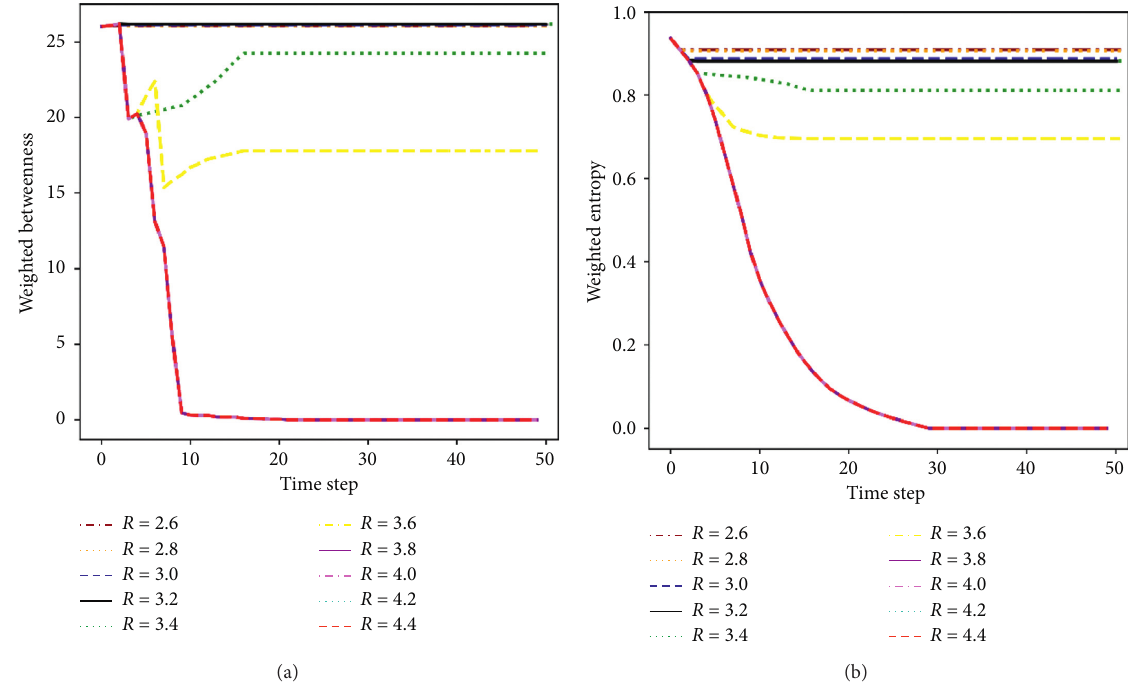
Figure 6: Changes of passenger-flow-weighted network reliability during cascading failure caused by the Century Avenue Station (a) for weighted betweenness and (b) for weighted entropy.